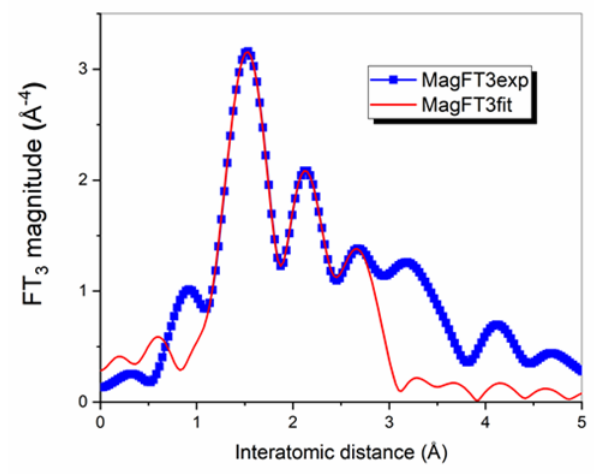
Figure 4. EXAFS FEFF9 calculations of IrQ(ppy) 2 .